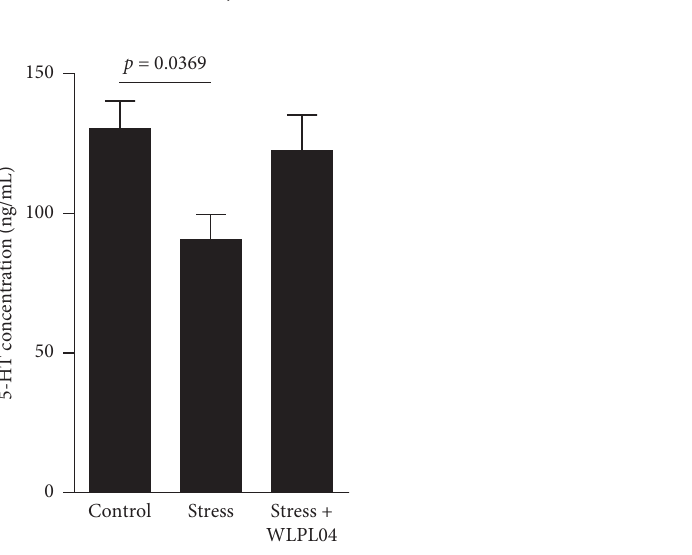
Figure 4: Chronic stress causes a decrease in the serum 5-HT concentration, and such effect is reversed by the L . plantarum WLPL04 treatment. Three independent experiments were conducted in each sample group.